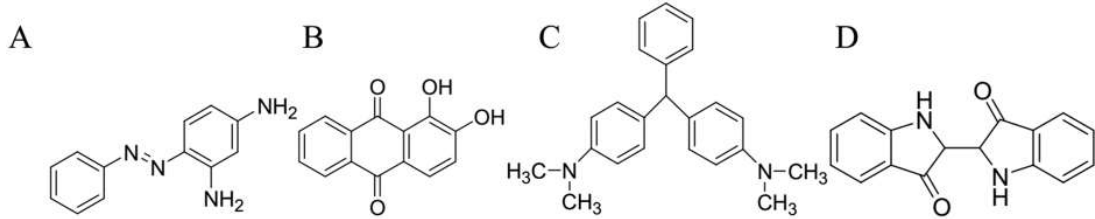
Figure 1. The fundamental structure of some synthetic dyes. ( A ) Azo dye (chrysoidine), ( B ) anthraquinone (alizarine), ( C ) triphenylmethane (malachite green), ( D ) indigo dye (indigo) [33]. Over 10,000 different types of commercial pigments and dyes are produced annually [34].